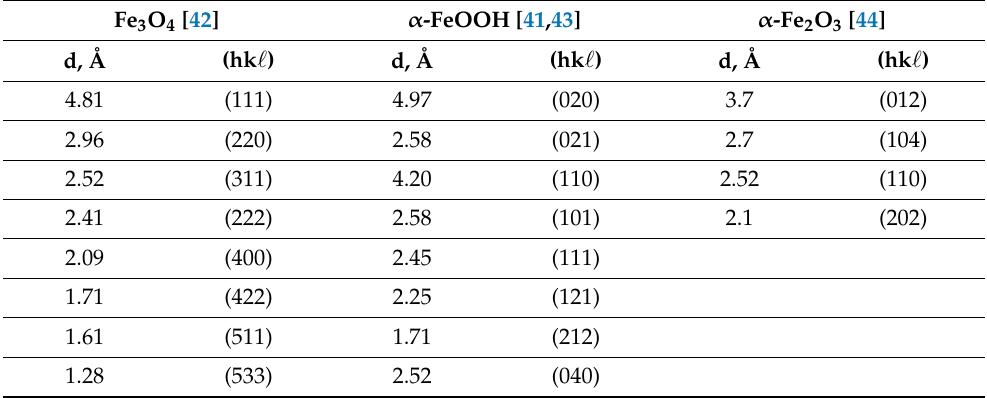
Table 3. Interplanar spacings of iron oxide and oxyhydroxide forming during ANPs synthesis.